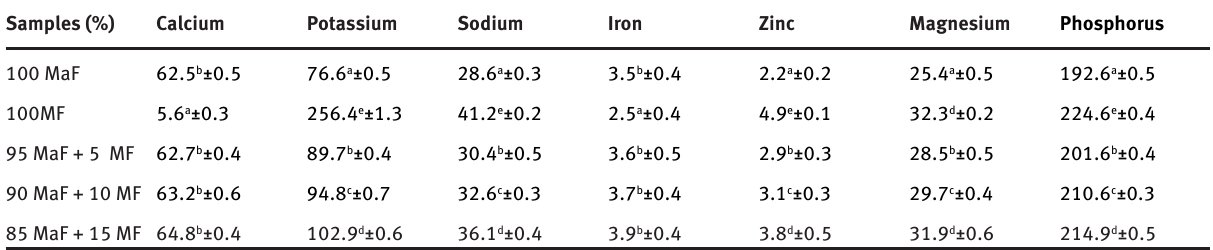
Table 3: Mineral content of maize (Zea mays) flour composited with mushroom (Pleurotus ostreatus) flour at different ratio (mg/100g) Samples